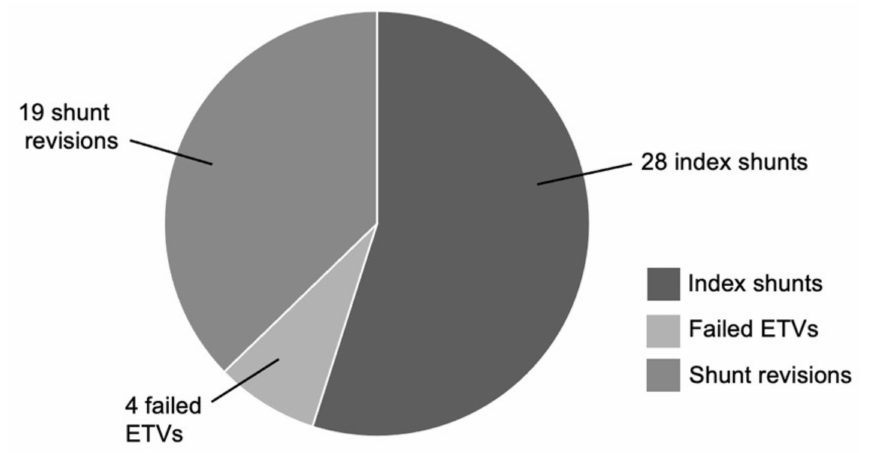
Figure 2. Breakdown of programmable shunt